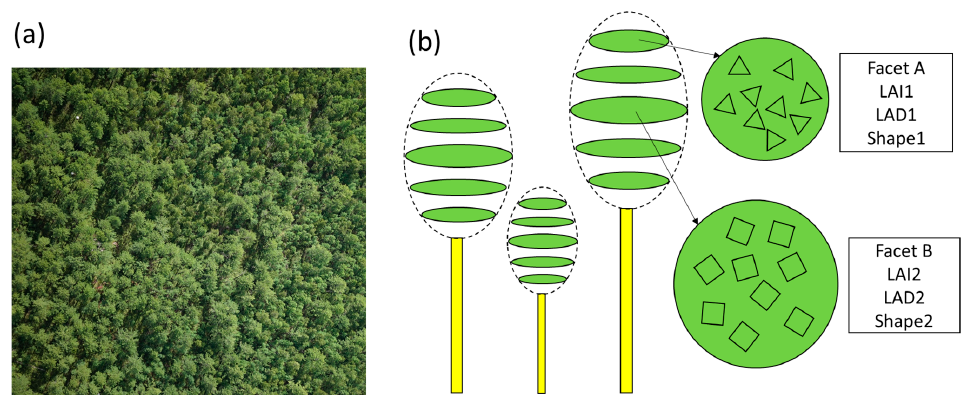
Figure 1. ( a ) Actual forest canopy and ( b ) illumination of plant objects. Horizontally arranged green facets are used to represent groups of small leaf facets in each layer and yellow facets are used to represent trunks.